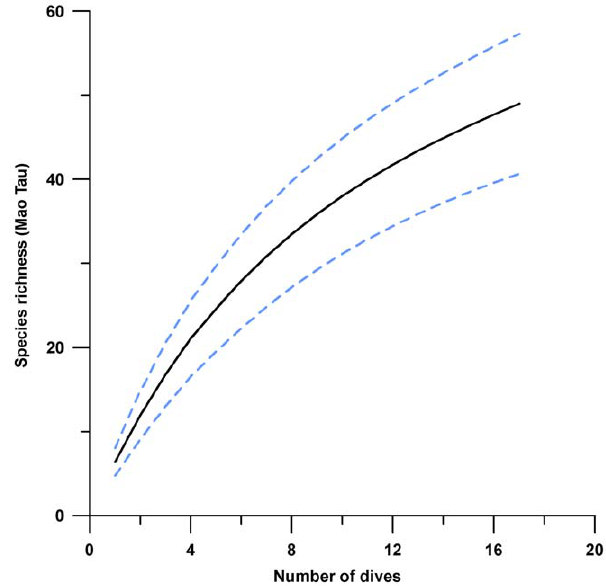
Figure 4. Species accumulation curve for Saba Bank gorgoni- ans. The graph shows a sample-based rarefaction curve (in black) based on 17 shallow and deep dives. The technique employs a Mao Tau estimator [21] of expected species richness with 95% confidence intervals (in light blue). The species accumulation curve is steeply inclined, not approaching asymptote. More gorgonian species remain to be discovered on Saba Bank, though richness is already higher than other study sites in the West Atlantic.